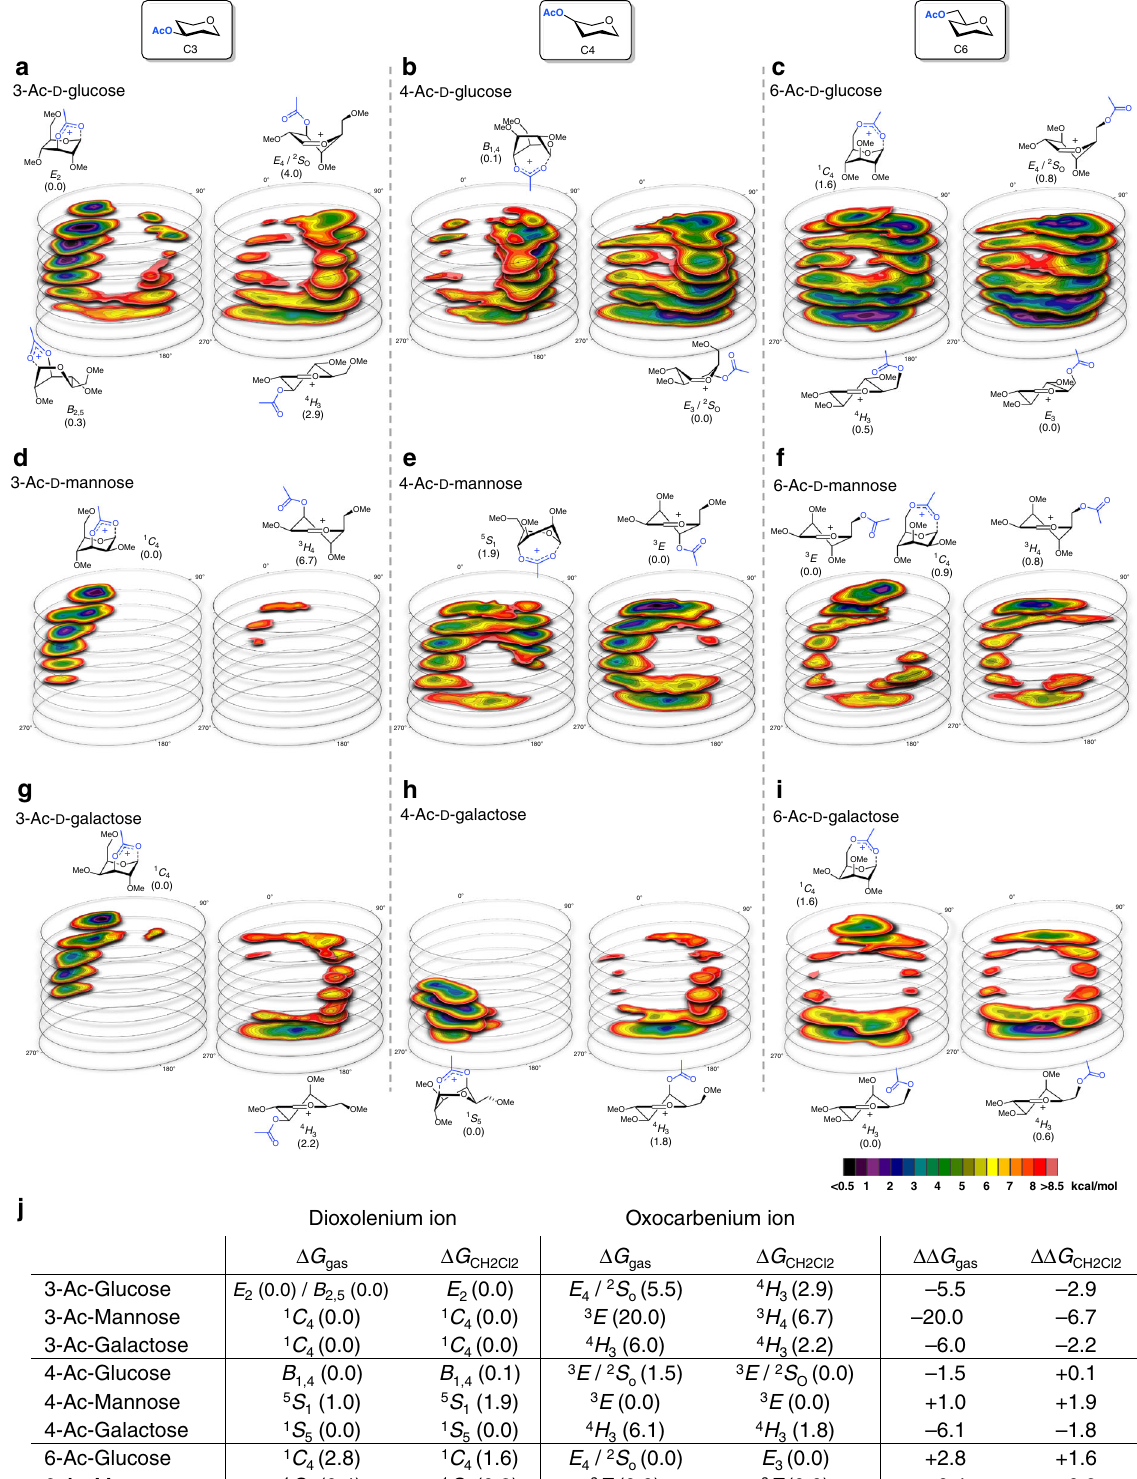
Fig. 5 CEL maps of selected glycosyl cations in which the local minima identi fi ed are shown with their respective energy 42 . Two acetyl ester rotamers (R1 and R2) were considered for all computed glycosyl cations generating two sperate CEL maps. All energies are as computed at PCM(CH 2 Cl 2 )-B3LYP/6- 311G(d,p) at 213.15 K and expressed as solution-phase Gibbs free energy. CEL maps for C3-acetyl pyranosyl ions ( a – c ), C4-acetyl pyranosyl ions ( d – f ), C6- acetyl pyranosyl ions ( g – i ). j Table summarizing the relative energy of the dioxolenium and oxocarbenium ion conformers in the gas- and